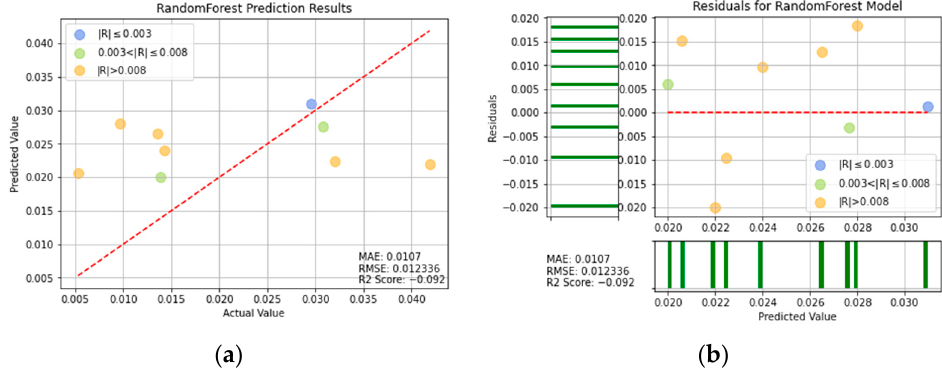
Figure 16. RF prediction results: ( a ) comparison of actual and predicted precision values, and ( b ) residual plot.